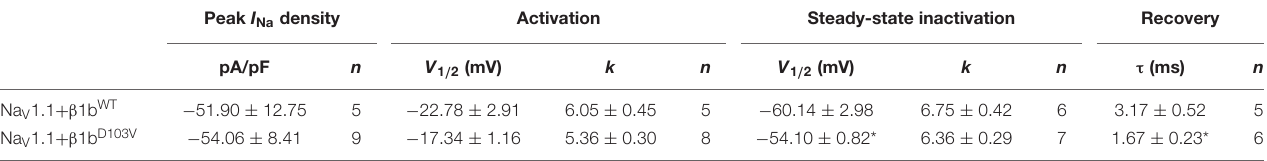
TABLE 7 | Biophysical parameters of Na V 1.1 cotransfected with β 1b WT or β 1b D103V . Peak I Na density Activation Steady-state inactivation